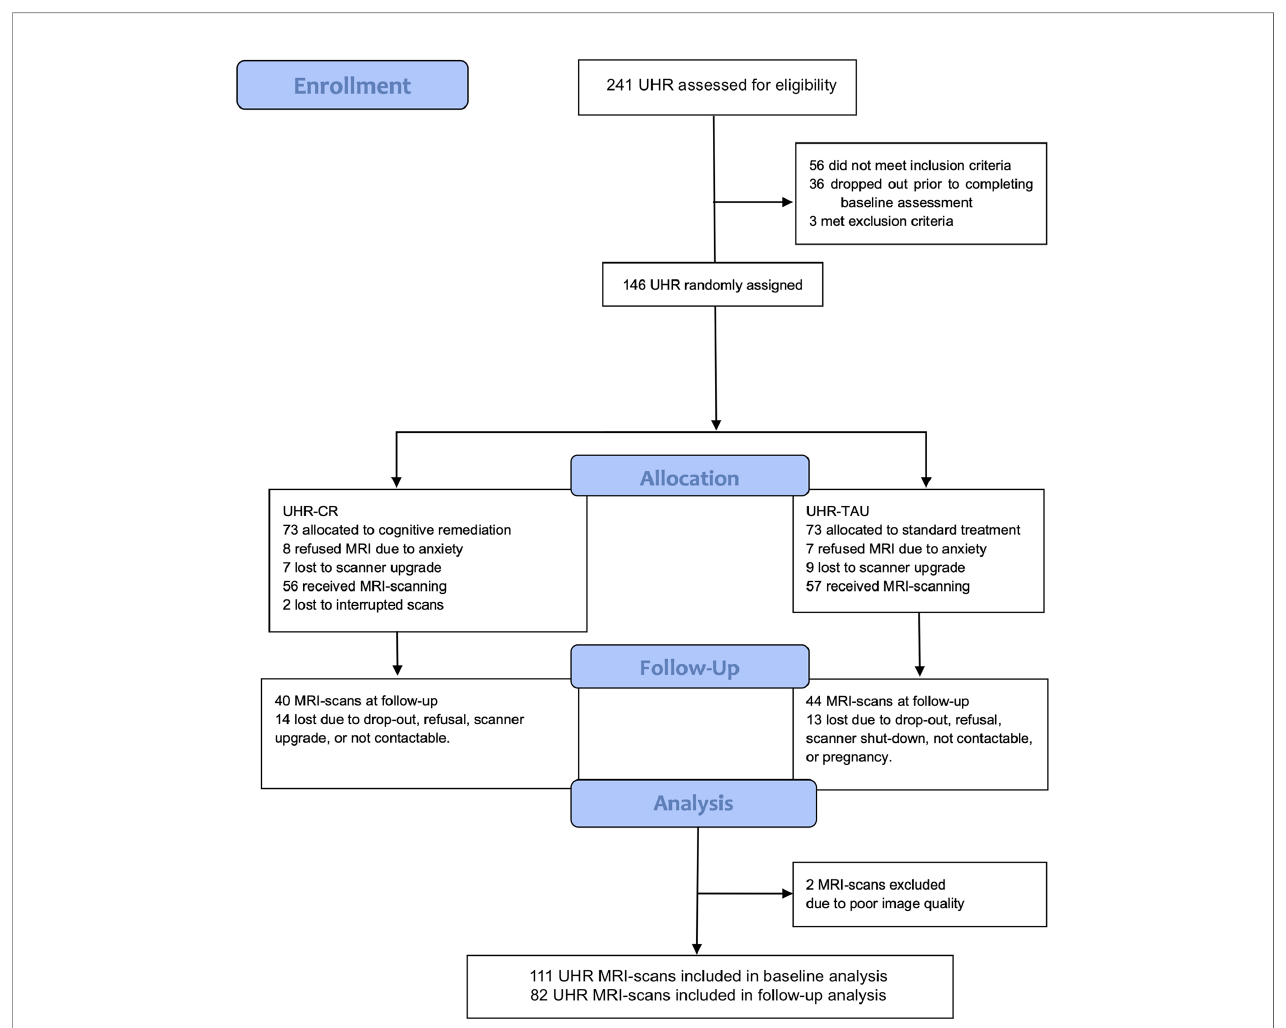
FIGURE 1 | Flowchart of the FOCUS trial. CR, cognitive remediation; MRI, magnetic resonance imaging; TAU, treatment as usual; UHR, ultra-high